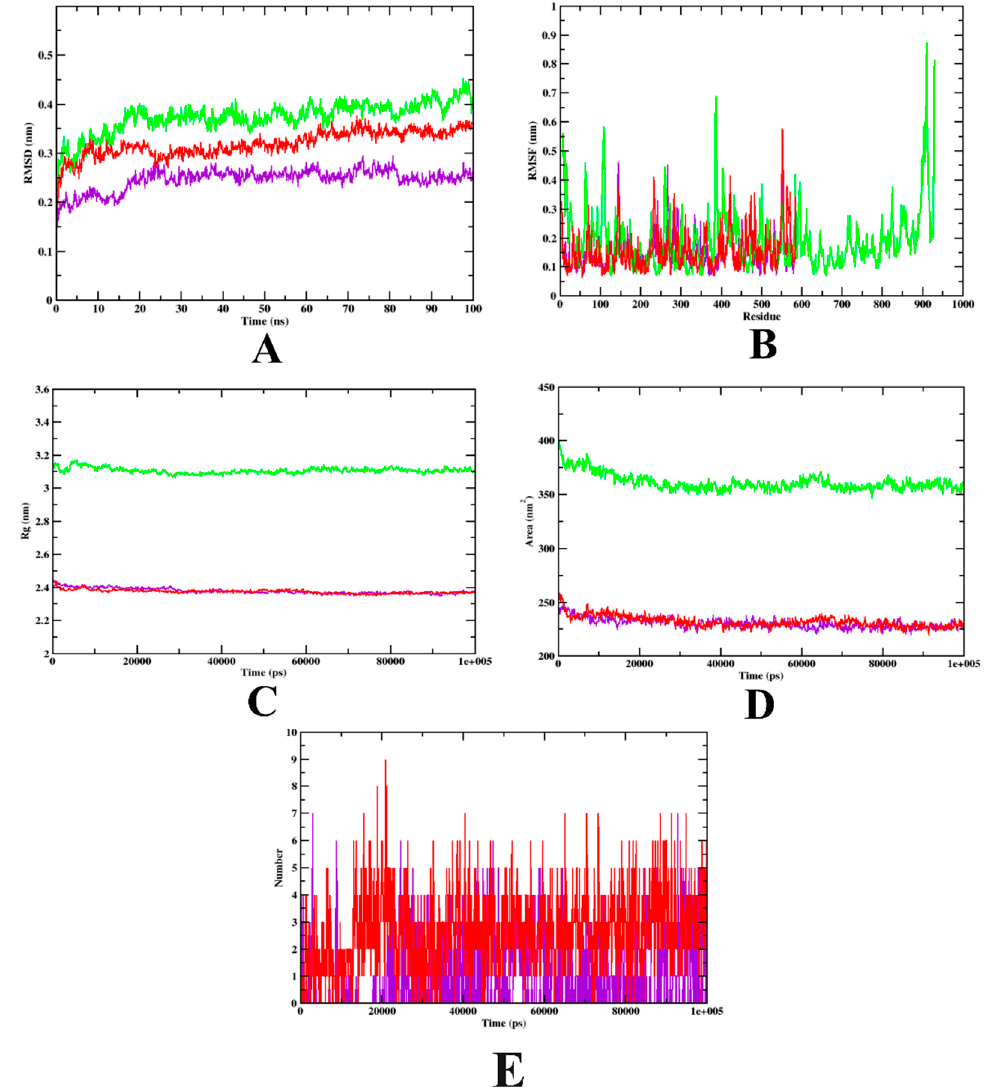
Figure 5. Analysis of RMSD, RMSF, Rg, SASA, and the number of hydrogen bonds of isoeugenol- (purple) and acarbose-bound (red) α -glucosidase complexes, as well as apo-protein α -glucosidase (green), at 100 ns. ( A ) Time evolution of RMSD values of both the complexes along with the protein. ( B ) RMSF. ( C ) Radius of gyration (Rg). ( D ) SASA. ( E ) Hydrogen bonds. Table 5. MD trajectory values of isoeugenol and acarbose complexed with α -amylase. Table 4. MD trajectory values of isoeugenol and acarbose complexed with α -glucosidase. MD Trajectory Values